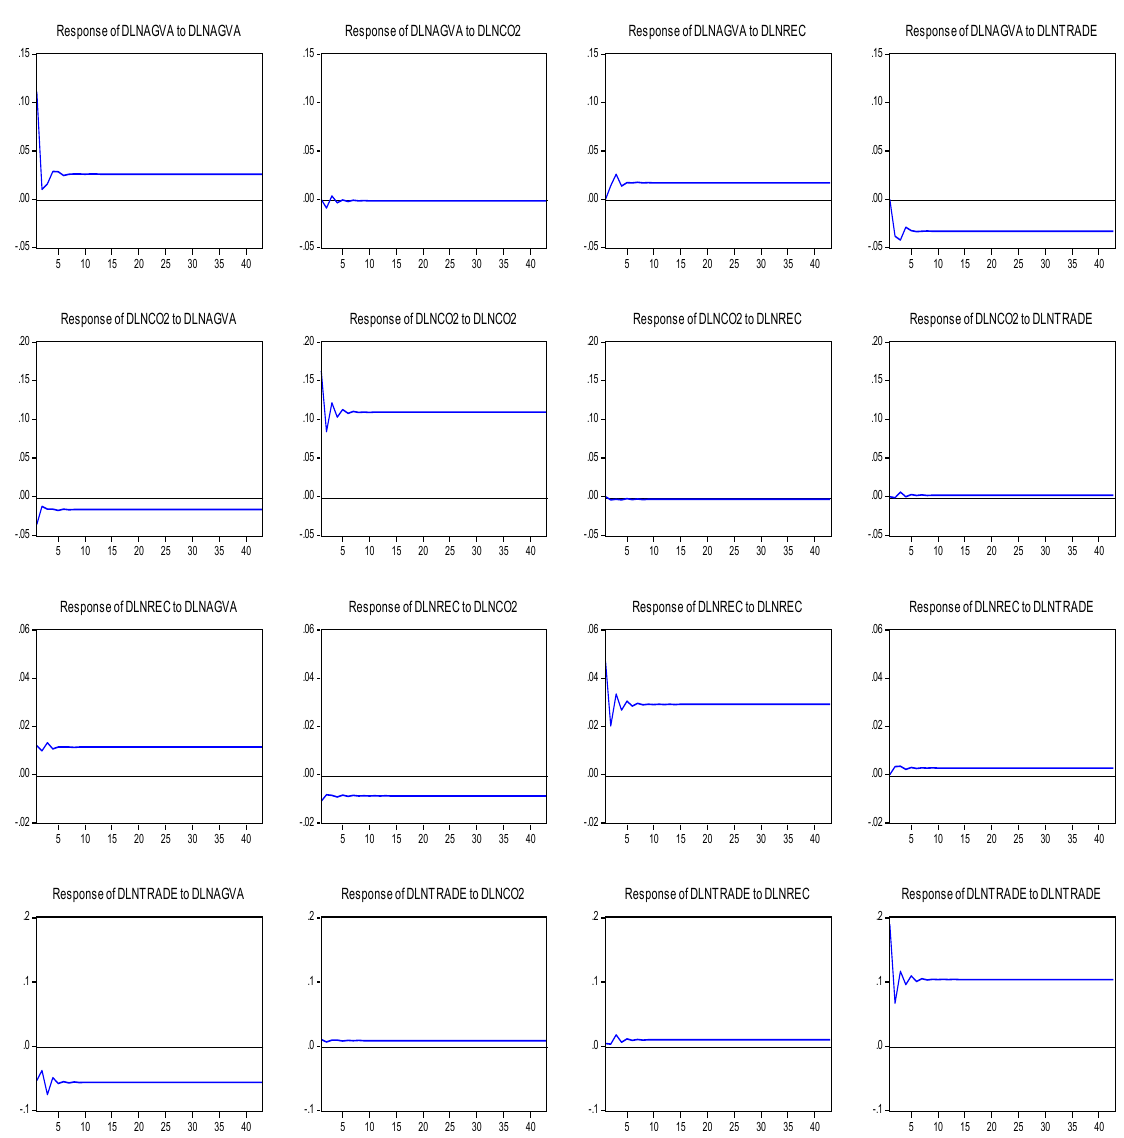
Figure A2. Policy response in light of African Union agenda (Agenda